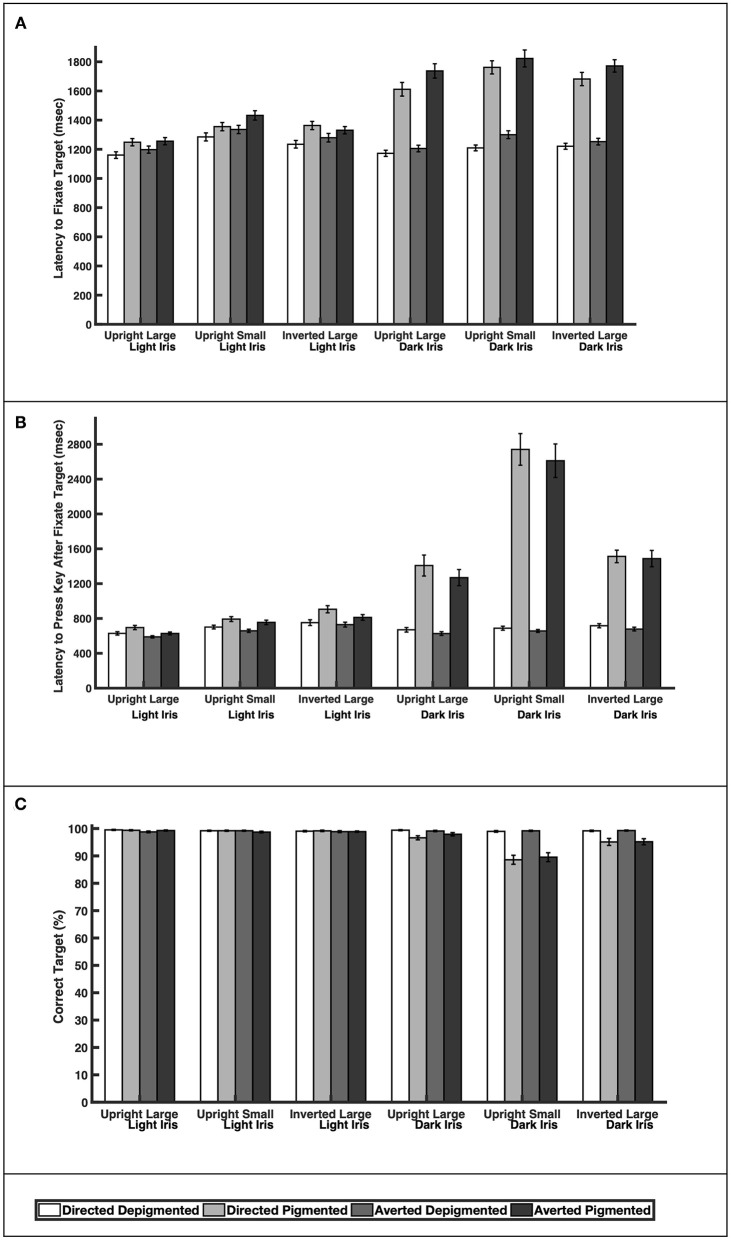
The (A) latency to initially fixate the target, (B) latency to indicate choice (via key press) after initially fixating the target, and (C) percentage of correct responses for large and upright faces, small and upright faces, and large and inverted faces. Means and standard errors are shown.